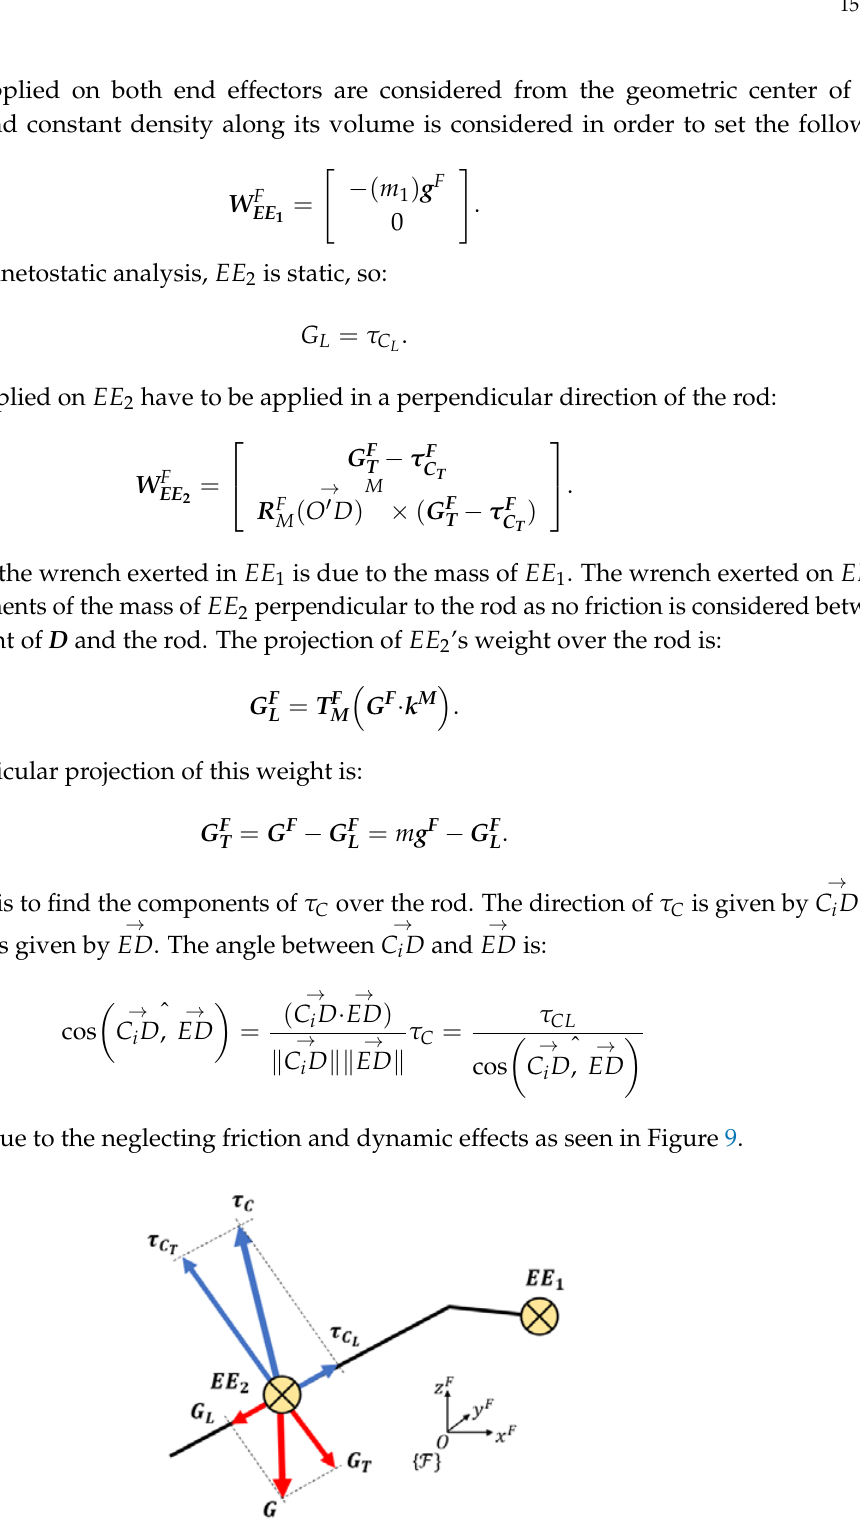
Figure 9. Wrenches applied to end effector 2.